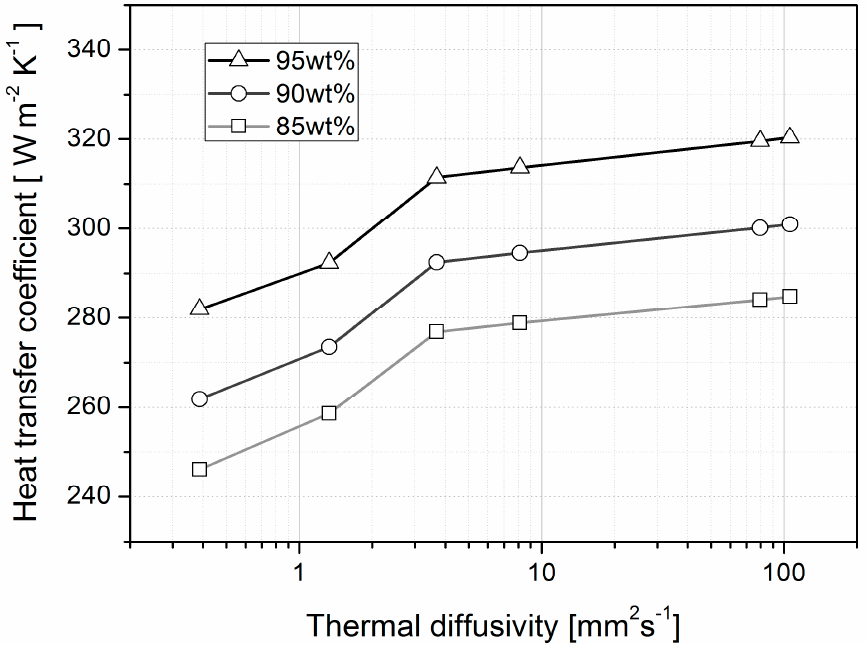
Figure 6. Heat transfer coefficient of the microthruster with materials of various levels of thermal diffusivity and different propellant enthalpies (85, 90, and 95 wt% hydrogen peroxide).